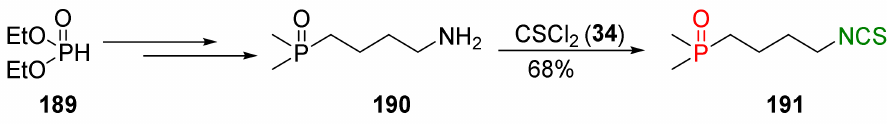
Figure 33. Synthesis of (4-isothiocyanatobutyl)dimethylphosphine oxide ( 191 ). Phosphorus analogues of SFN 191 , as well as sulforaphane ( 24 ), were evaluated in vitro as inducer potencies of NAD(P)H:quinine oxidoreductase (QR) in murine hepatoma cells (Hepa 1c1c7) (Table 7). Table 7. Effects of SFN and its analogues 191 on inducer potency for QR in Hepa 1c1c7. Compound CD ( µ M) 191